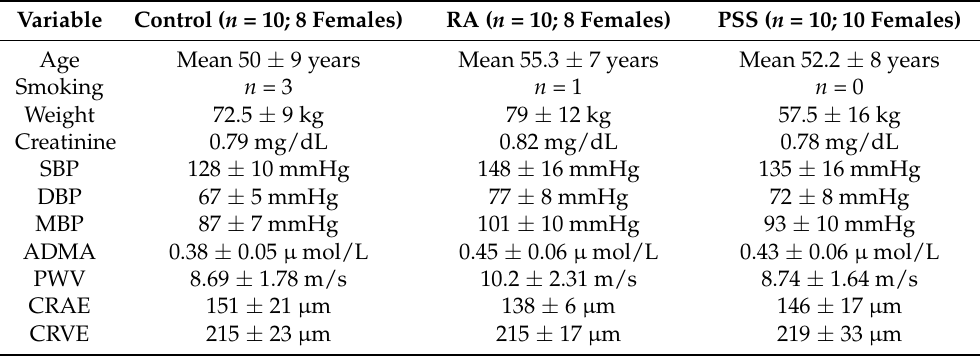
Table 1. General data for the participants. Data are shown as mean ± standard deviation. Legend: RA: rheumatoid arthritis; PSS: primary Sjögren